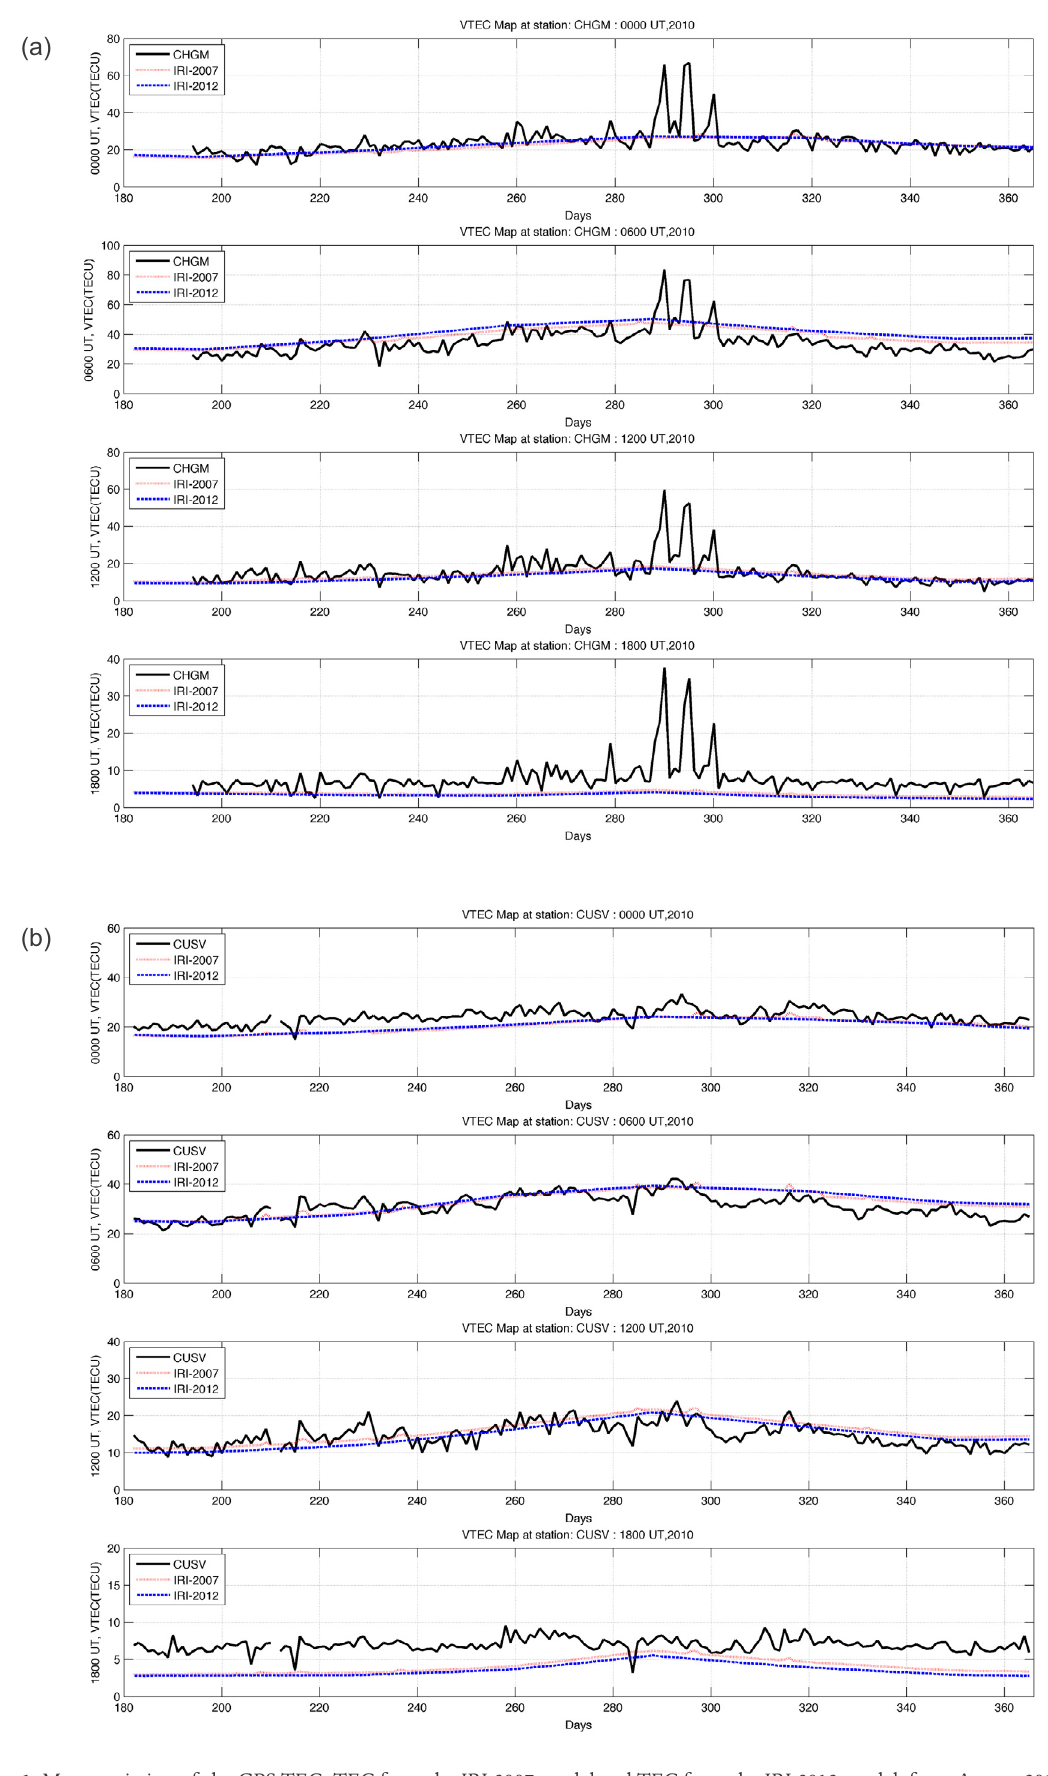
Figure 1. Mean variation of the GPS TEC, TEC from the IRI-2007 model and TEC from the IRI-2012 model, from August 2010 to Decem- ber 2010 at CHGM and CUSV respectively during sunrise, midday, post sunset and